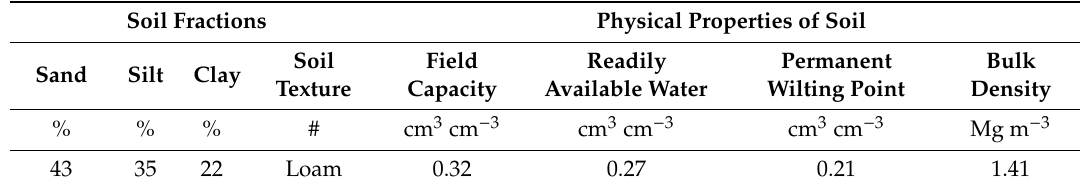
Table 1. The summary of soil physical